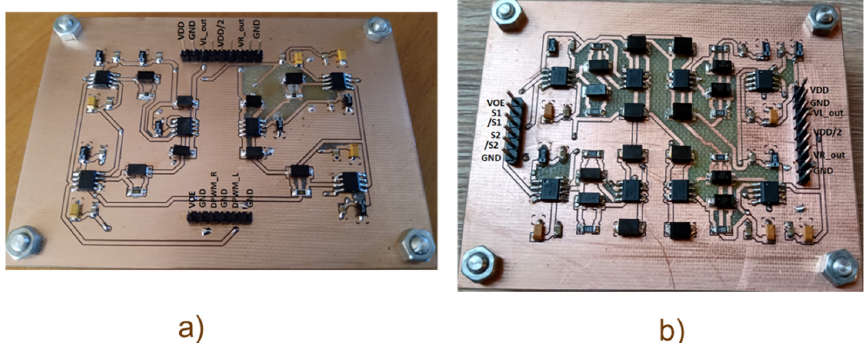
Figure 12. Photographs of the two PCBs containing the output stages of ( a ) a conventional Class-BD amplifier (Figure 3), and ( b ) a Class-BD amplifier implemented on complementary MOSFET pairs (Figure 5).